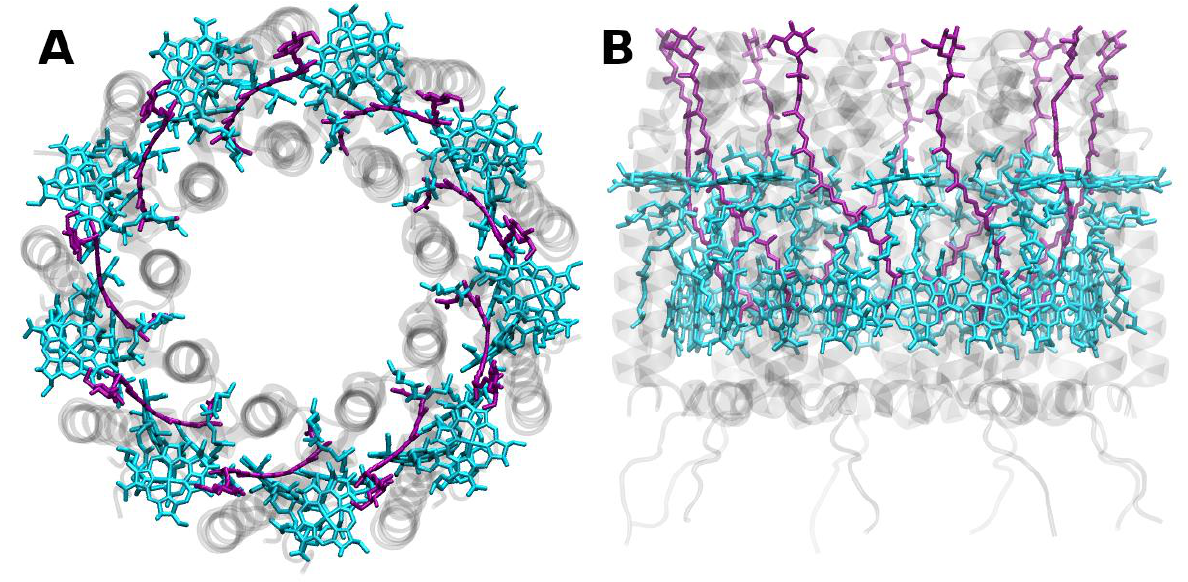
Figure 8. Structure of the purple-bacterial peripheral antenna complex (LH2) from Rhodoblastus acidophilus at 2.45 Å resolution, PDB entry 2FKW [87]. ( A ) Top view with regard to the bacterial membrane plane, seen from the cytoplasm. ( B ) Side view with regard to the bacterial membrane plane. The protein backbone is shown in grey. Bacteriochlorophyll a is shown in cyan, rhodopin glucosides (carotenoids) in